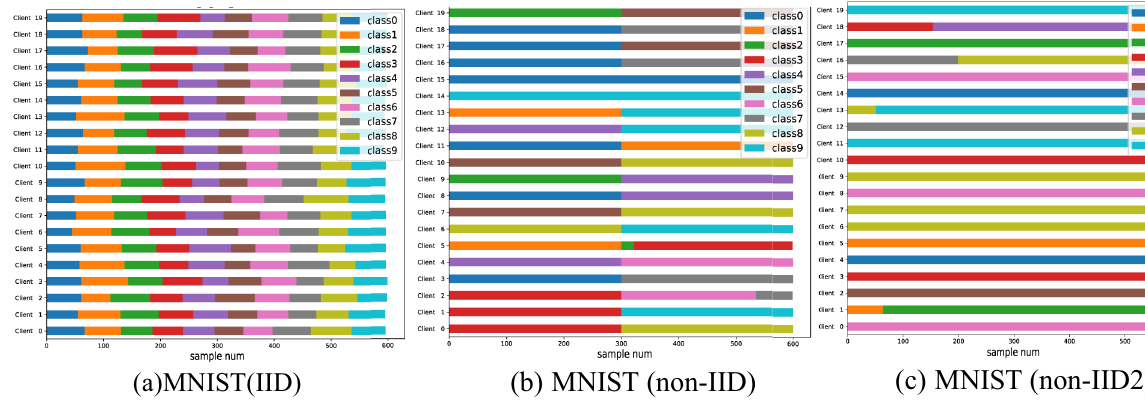
Fig. 1 Data distribution of the top 20 clients in the MNISTdataset